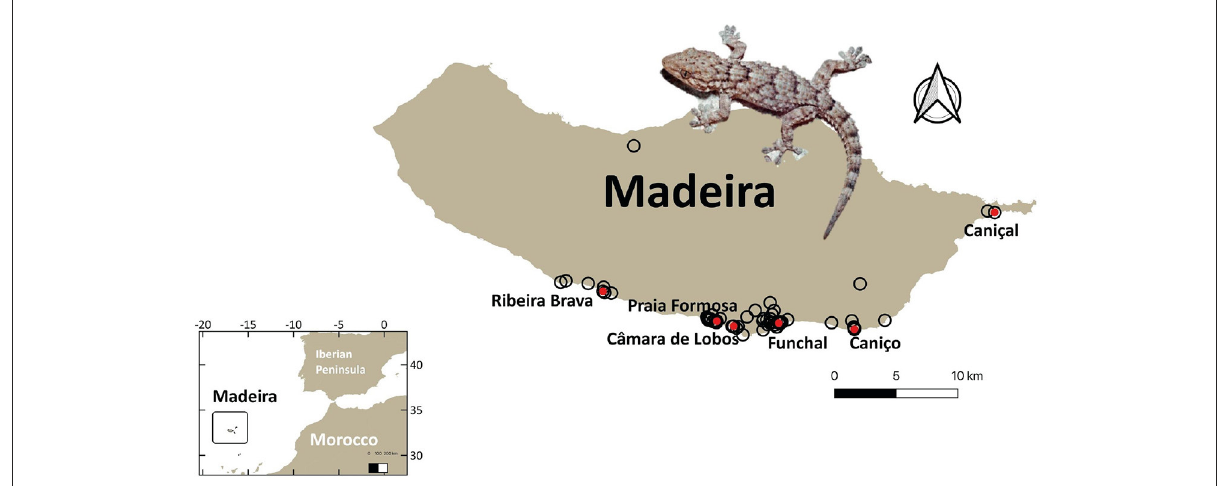
FIGURE1 Known distribution records of the Moorish gecko Tarentola mauritanica in Madeira Island represented by black hollow circles (retrieved from the Global Biodiversity Information Facility (GBIF) database, www.gbif.org), and sampling sites depicted with red circles. The inset map denotes the geographic location of Madeira